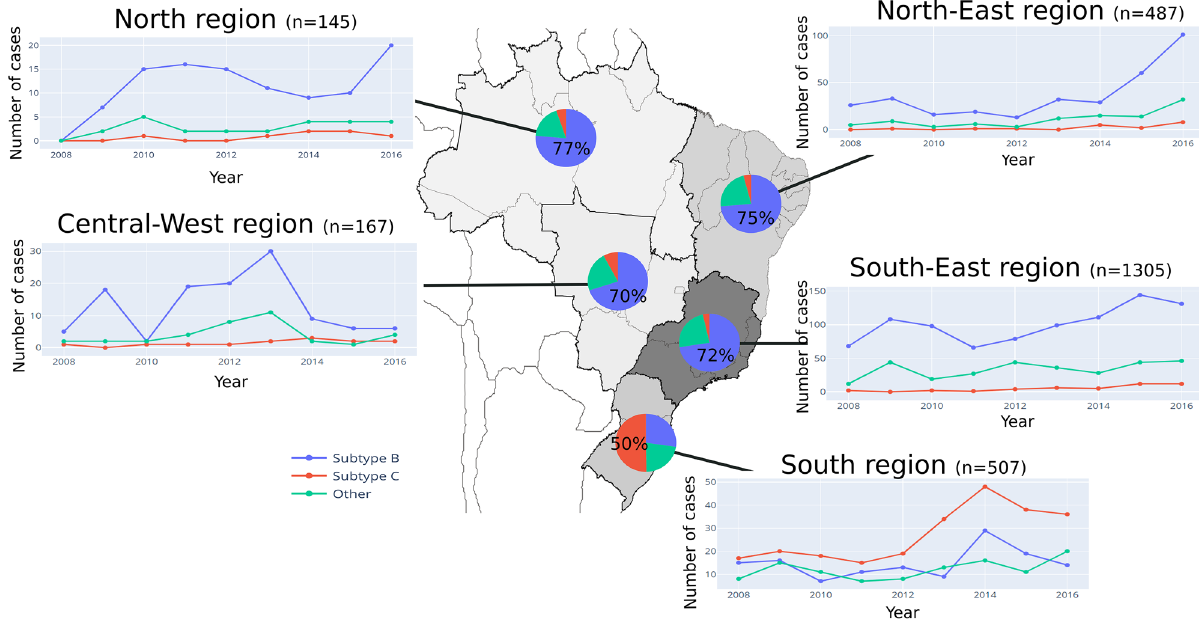
Figure 1. HIV-1 subtype distribution in Brazil nation-wide data obtained from 2008 to 2017 (n = 2611). ( A ) The pie charts represent the prevalence of subtypes B (blue), C (red) and other subtypes and recombinants (green) in the five macro-regions of Brazil. The shade of grey indicates the prevalence of HIV-1 (all subtypes) in each region (raging from the highest prevalence in dark grey to the lowest prevalence in light grey). ( B ) Absolute number of HIV-1 cases of subtype B, C and other subtypes in all Brazilian regions per year. Inkscape 0.92.4 (https:// inksc ape. org/) was used to create the